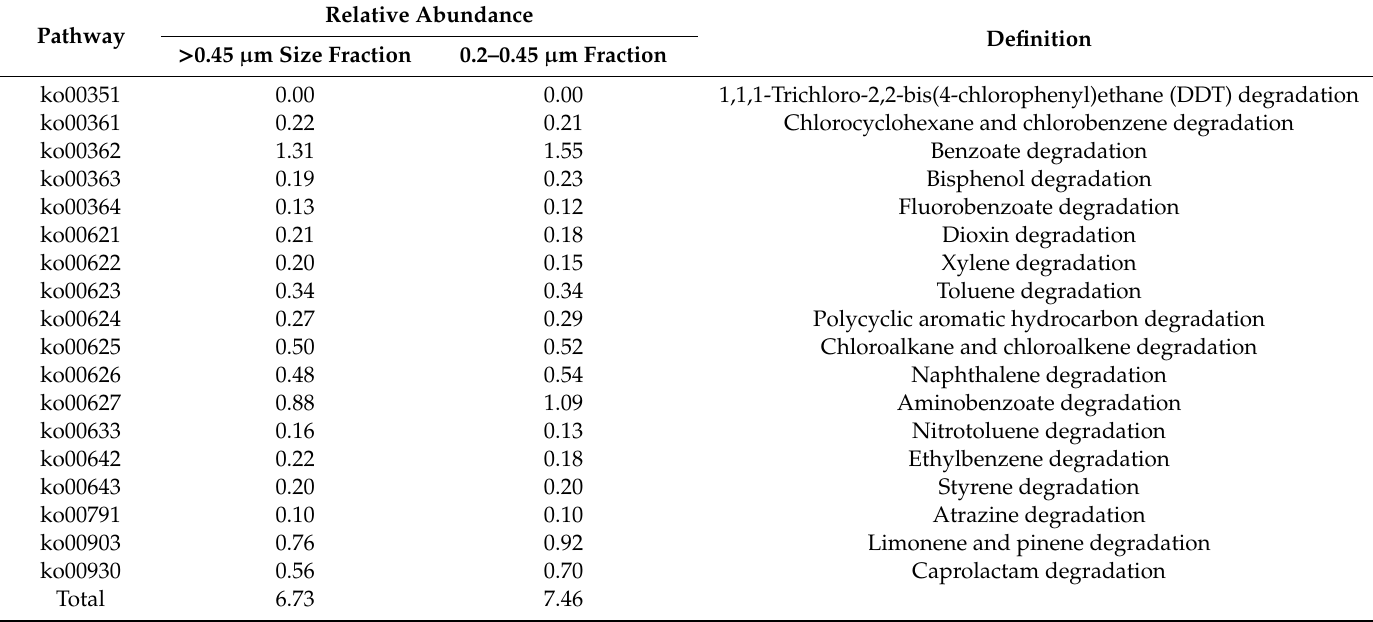
Table 5. Kyoto Encyclopedia of Genes and Genomes (KEGG) metabolic pathways involved in the degradation of aromatic compounds in bacterial samples.